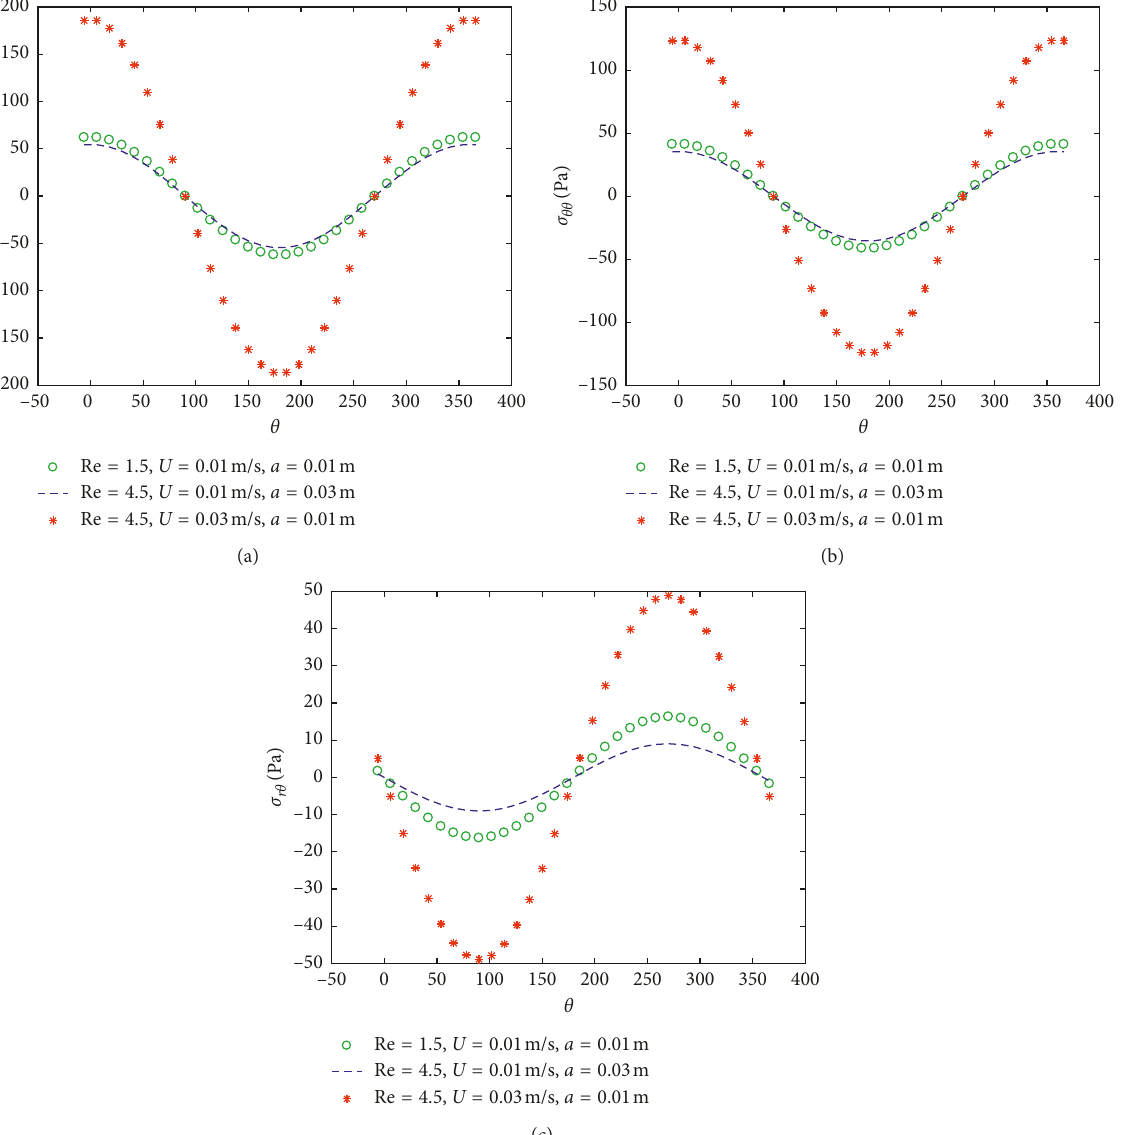
Figure 12: Angular distribution of normal stress of phonon under different Reynolds number at r � 1 . 55 a and t � 350 μ s : (a) radial normal stress, (b) circumferential normal stress, and (c) shear stress σ r